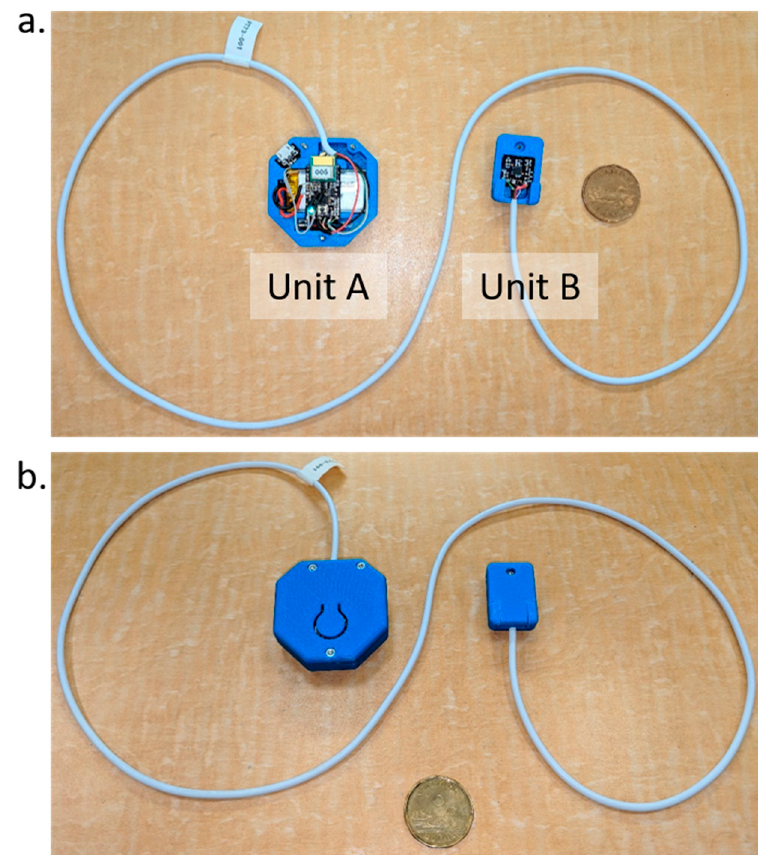
Figure 1. Wearable device for back posture monitoring, size compared to a Canadian dollar coin: ( a ) circuitry view, and ( b ) closed device.